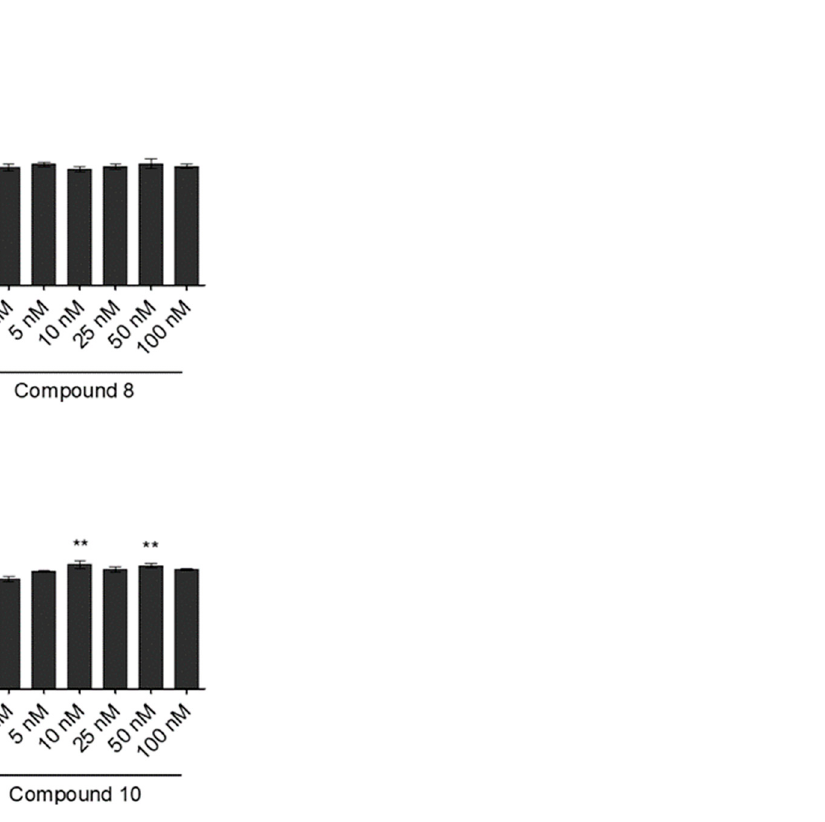
Figure 4. Effects of compounds 8 and 10 on cell viability in H9c2 cardiomyocytes. H9c2 cells were treated with vehicle (Control) or increasing concentrations of ( A ) compound 8 (1 nM–100 nM) or ( B ) compound 10 (1 nM–100 nM) for 24 h. Cell viability was determined using the MTT assay and was expressed as the percentage of control cells exposed only to vehicle (indicated as Control). Results are represented as mean ± SEM ( n = 6 per group). Significant differences were detected by one-way ANOVA followed by Dunnett’s test, p < 0.01 (**) vs. Control group.